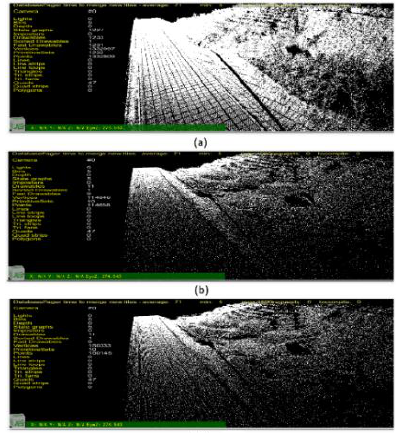
Fig. 6 Comparison of the two kinds of mesh filtering.